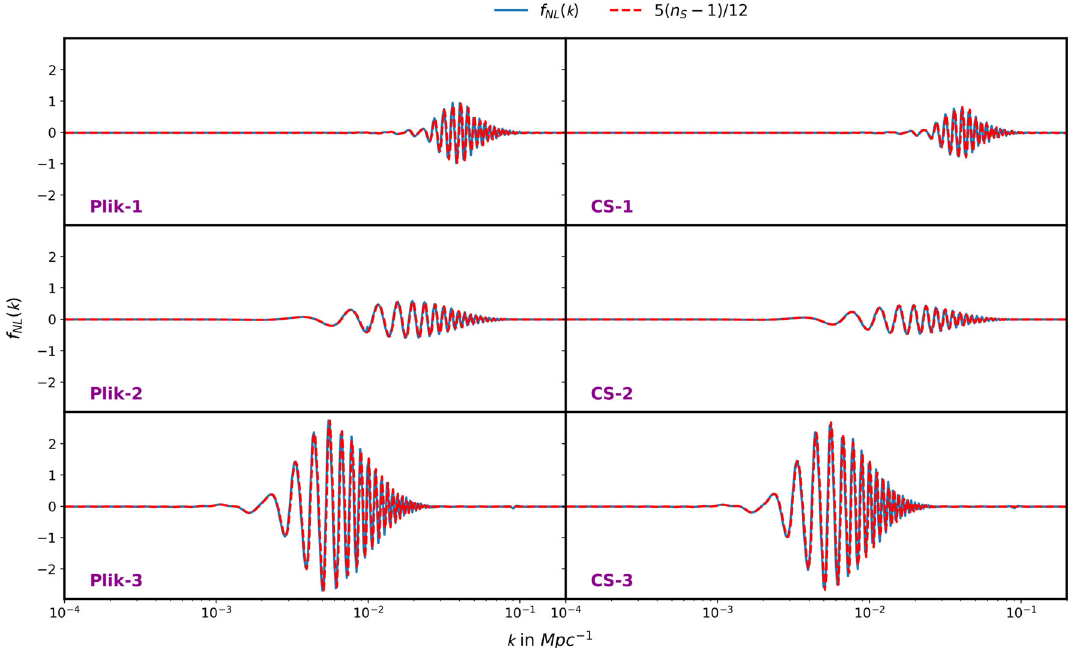
Fig. 10 Verifying consistency relation (Eq. 6) for the best-fit candidates to the Plik-bin1 (left side) and CamSpec clean (right side)